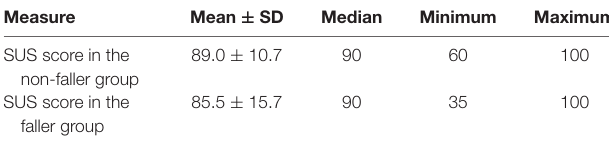
TABLE 5 | Results of the SUS assessment of the VIRVEST system in the faller and non-faller groups. Measure Mean ± SD Median Maximum SUS score in the SUS score in the